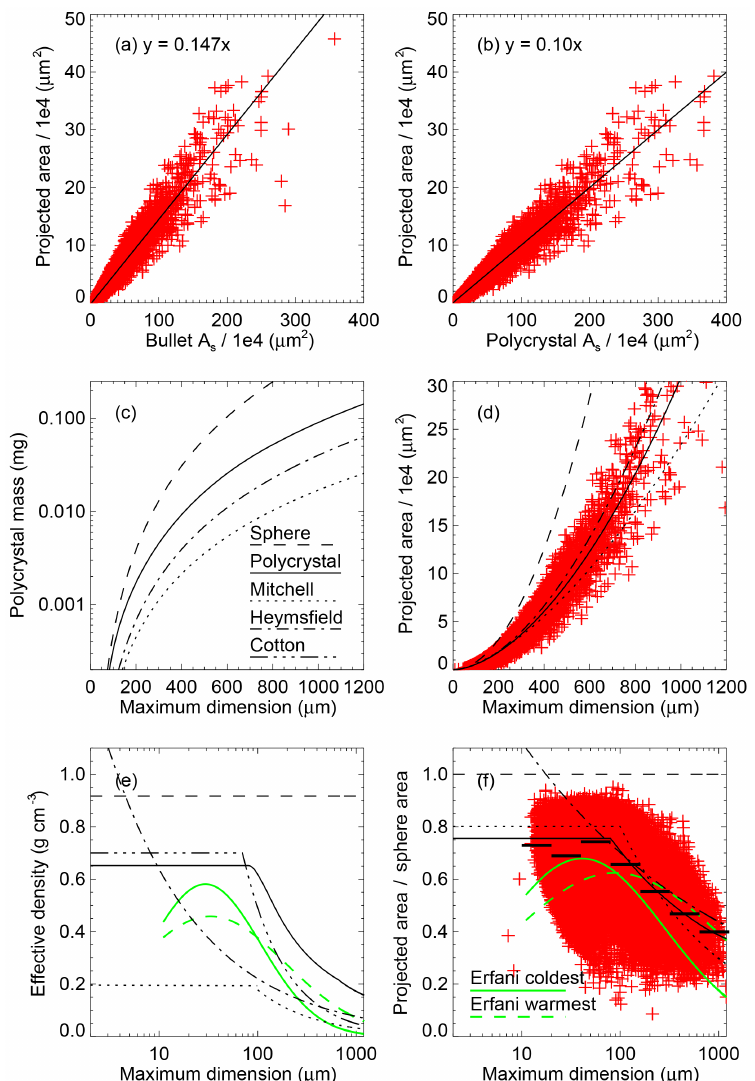
Figure 13. Polycrystal model: measured and calculated properties of unclassified ice crystals (red symbols). Line types indicate derived ice properties as follows (see legends in panels c and f ): a sphere, a polycrystal based on a six-arm bullet rosette (see Sect. 4.4 and Appendix A4), five-arm rosettes from Mitchell et al. (1996), and cirrus crystals from Heymsfield et al. (2002), Cotton et al. (2012), and Erfani and Mitchell